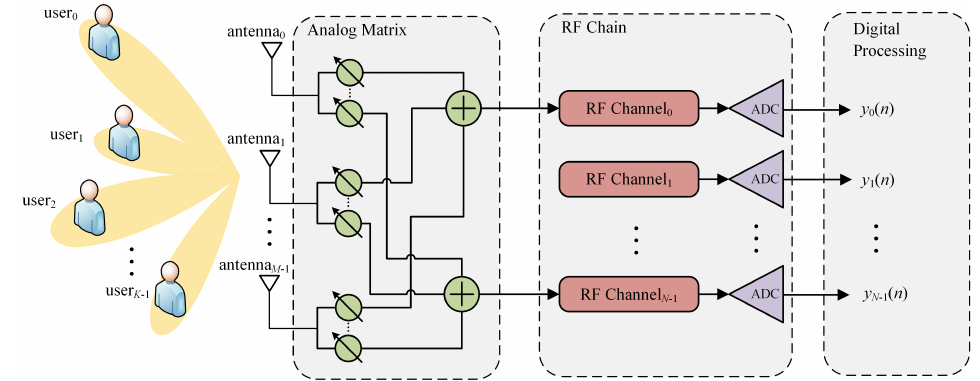
Figure 1. Large-scale array system based on a hybrid structure serving multiple users simultaneously (the BS adopts N radio frequency links to serve K